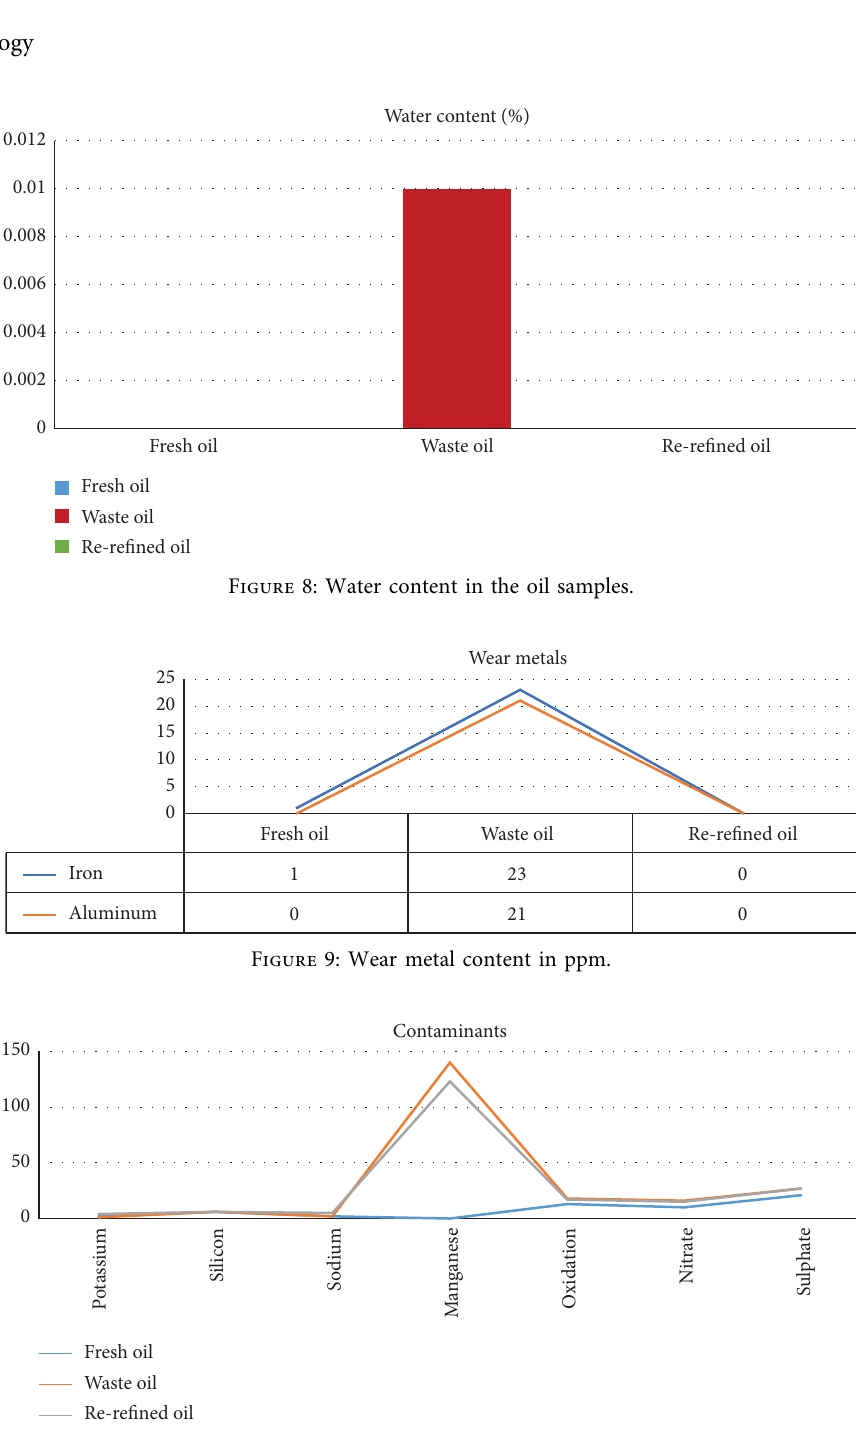
Figure 10: Contaminants found in the oil